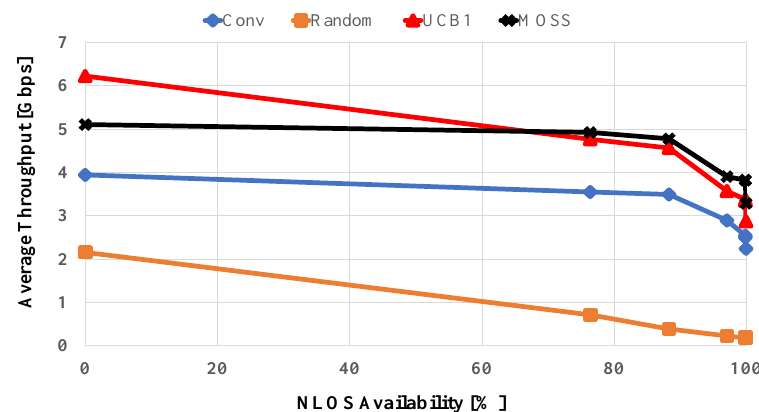
Figure 6. Average Throughput vs. NLOS availability for 60 Devices.